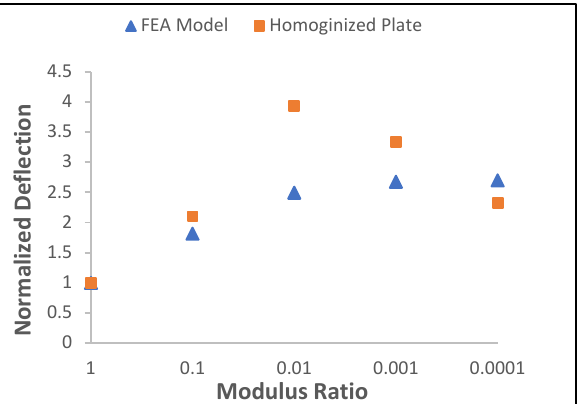
Figure 12. Effects of Young’s modulus ratio, λ , on the lateral deflection at the center of the bi-material architected plate under lateral pressure. a = g = 5, s = t = 1, θ = 30 ◦ . Deflections are normalized to the lateral deflection of the center of a plate with λ =